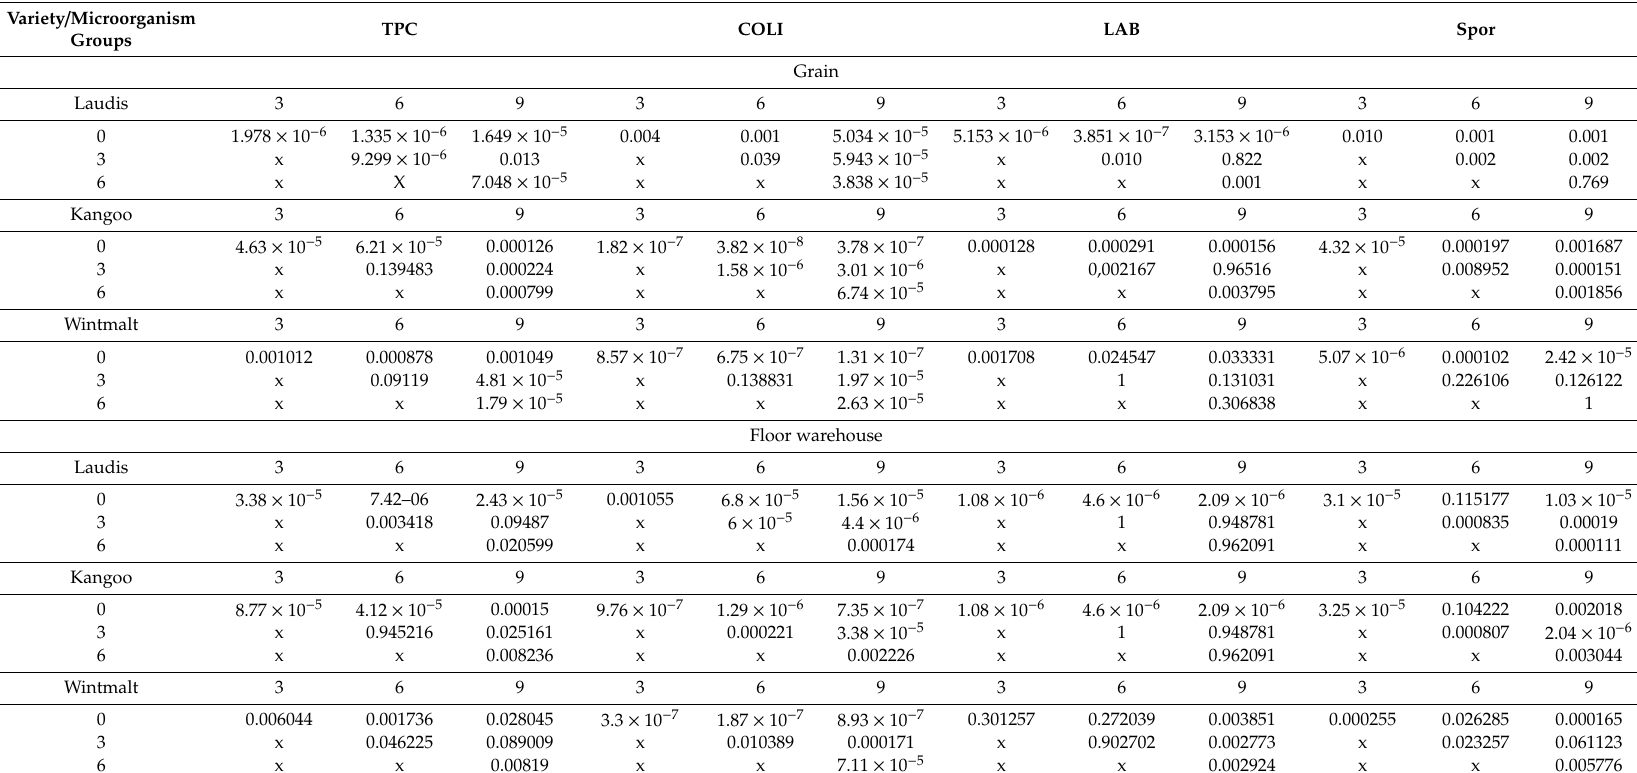
Table 4. p -values among analyzed barley depending on the time and type of storage of the three varieties of barley ( p < 0.05). Variety / Microorganism